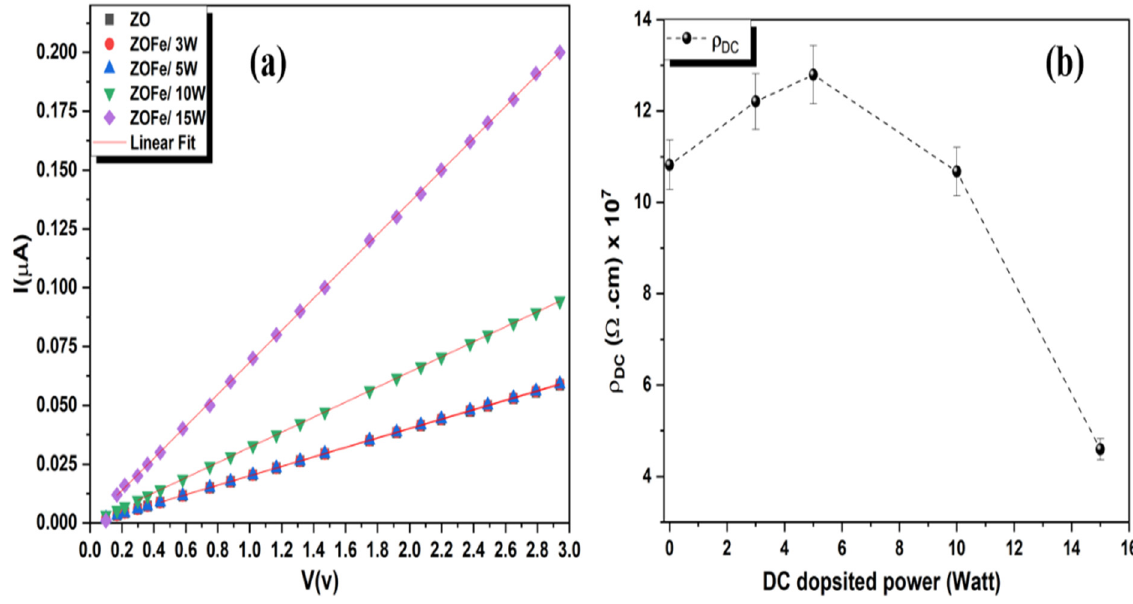
Figure 17. ( a ) I-V characteristics of undoped and Fe doped ZO thin films and ( b ) variations of the electrical resistivity ρ DC with Fe concentration of all investigated thin films.